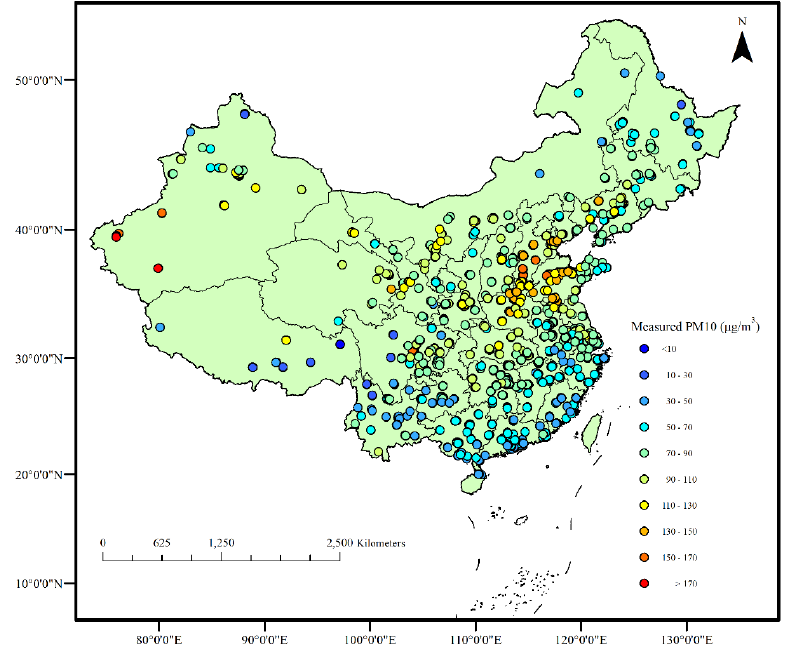
Figure 7. Annual average ground measured PM 10 mass concentrations depicted using color-classified symbols (See legend at right).